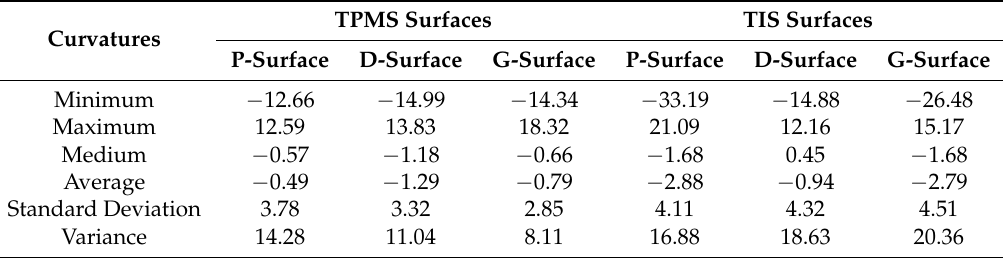
Figure 10. Two views of the TIS G-surface generated from two connecting tetrahedrons. Table 2. Statistical analysis to the curvatures of TPMSs and TISs.